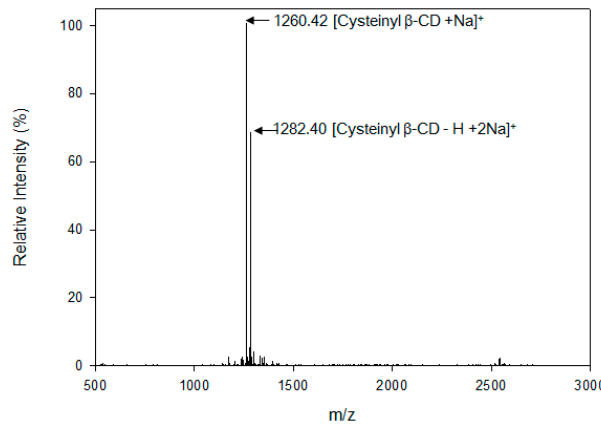
Figure 1. MALDI TOF mass spectrum of cysteinyl β -CD.